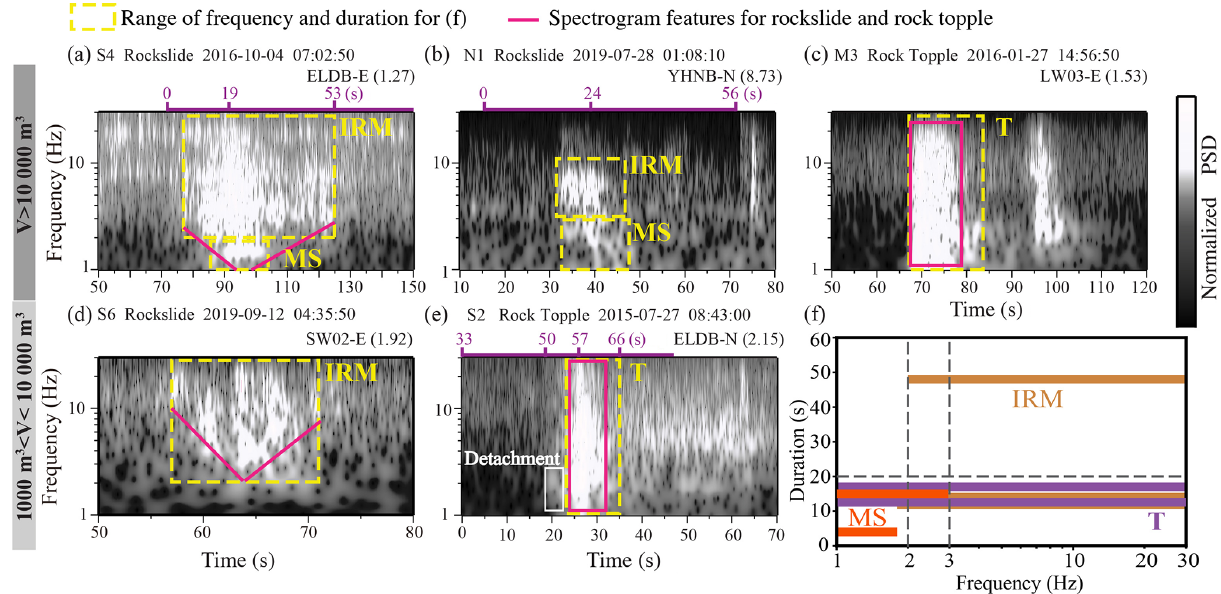
Figure 6. Spectrogram of five events and the classification of physical processes by spectrogram features, frequency, and duration. The rows are separated for the different scales of failure volumes. (a–e) Spectrograms of different events. The panel headings show the event number, the physical process, and the starting time of the x axis. The text in the top right displays the station name with the component and the epicentral distance (km). The purple bars above panels (a) , (b) , and (e) are the durations (in seconds) of the video with the time points (Table S2). (f) Sliding and toppling processes are distinguished by the frequency and event